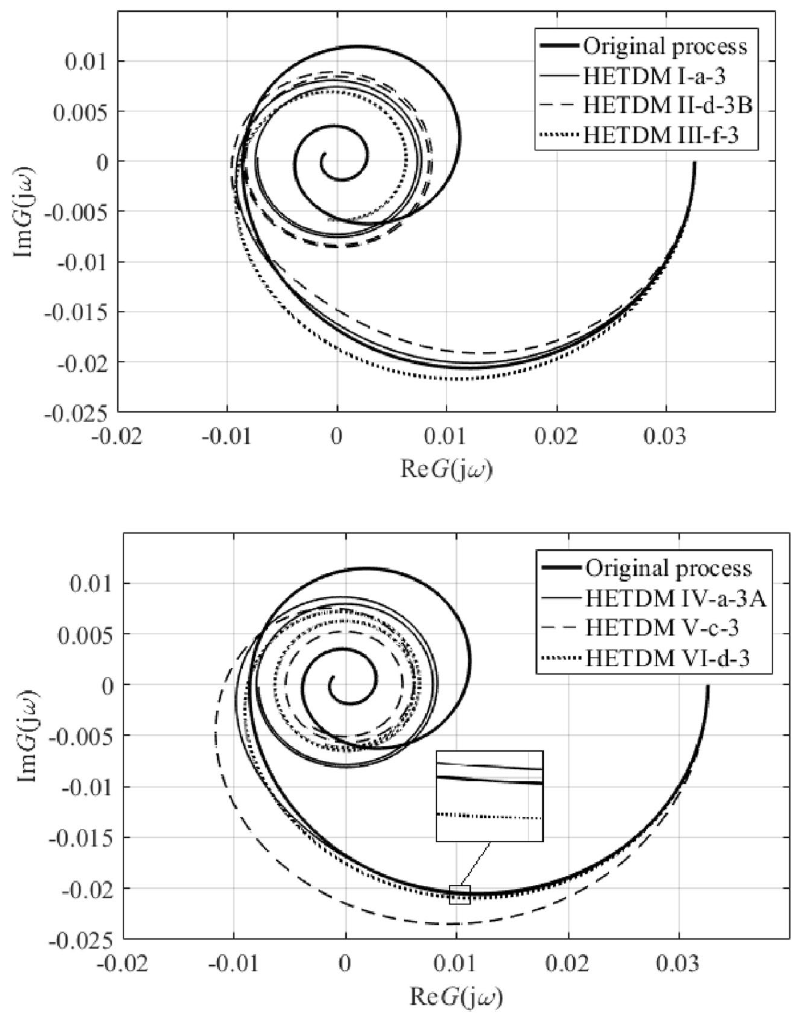
Figure 18. Comparison of selected HETDM Nyquist plots (vs. the original process response)—NM method used for complete transfer function parameters